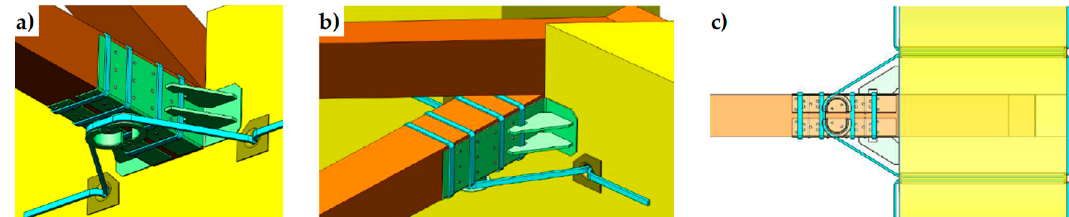
Figure 8. Connections between orthogonal walls, with details of the arrangement of the ribbons in the thickness: ( a ) at a building corner and ( b ) at an intersection between walls.